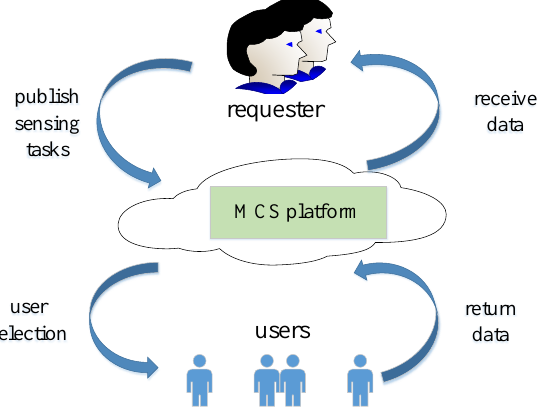
Figure 1. Architecture of typical mobile crowd sensing (MCS)